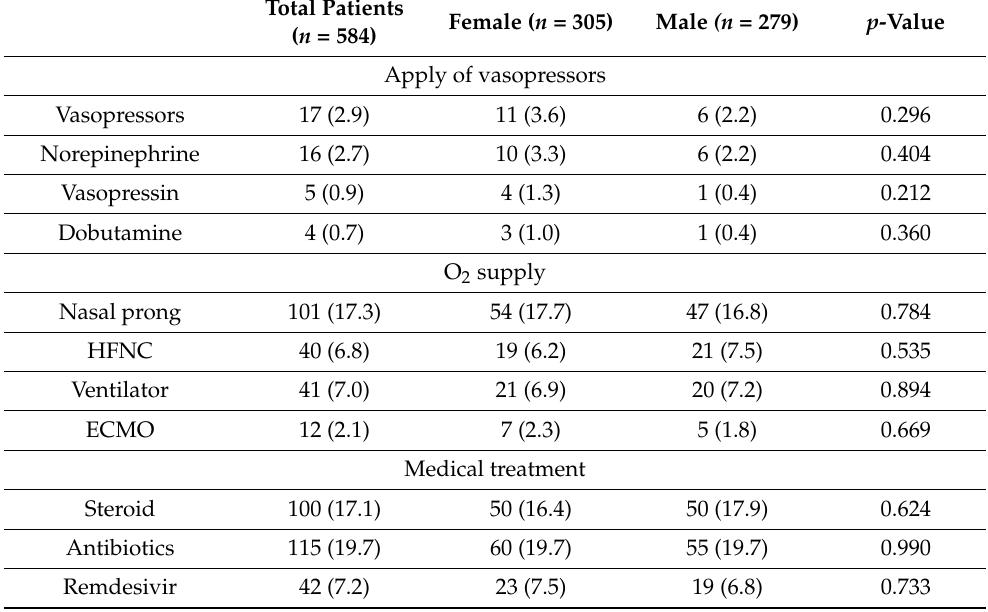
Table 3. Treatment and prognosis of the study